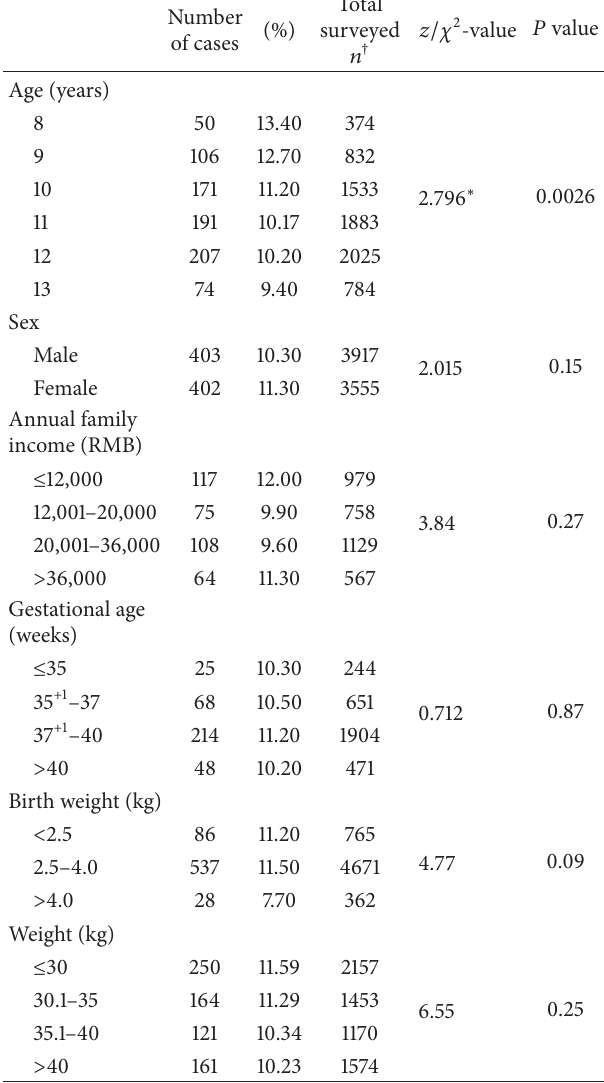
Table 1: Demographic characteristics-specific prevalence of IBS in